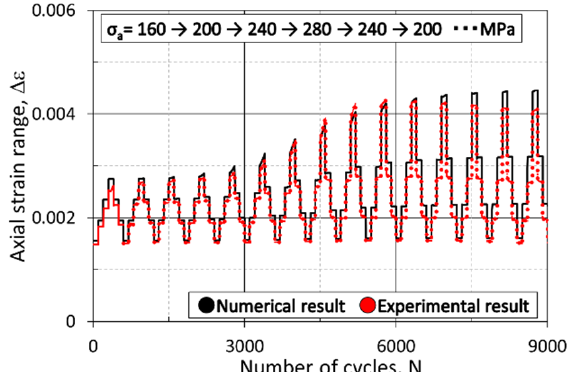
Figure 10. Numerical relationships between ∆ ε and the number of cycles under the repeated increasing and decreasing amplitude loading condition.